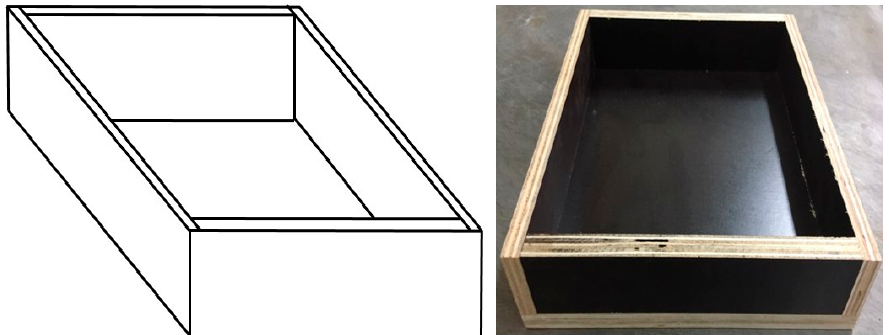
Figure 1. A mold for specimen of a place-type resilient material.